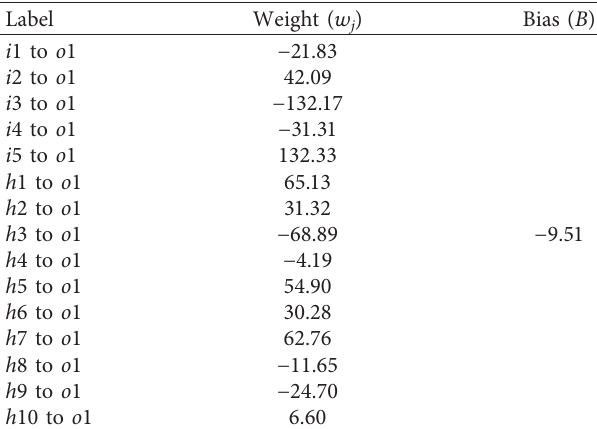
points in figure (red dots) quite approximates the green line (perfect prediction x � y ). Finally, the frequency distribution of the ratio between the actual and predicted values is shown in Figure 9. The mean, median, and mode values were 0.991, 0.973, and 0.991, respectively, with a 14% coefficient of variation. Since the mean, median, and mode are so close,